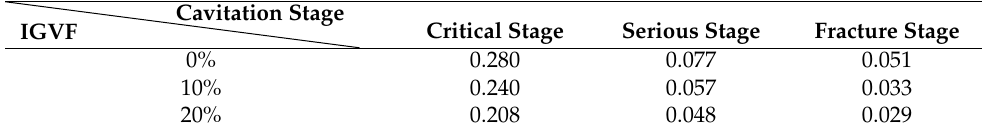
Table 2. The cavitation number under different IGVFs at each cavitation stage.